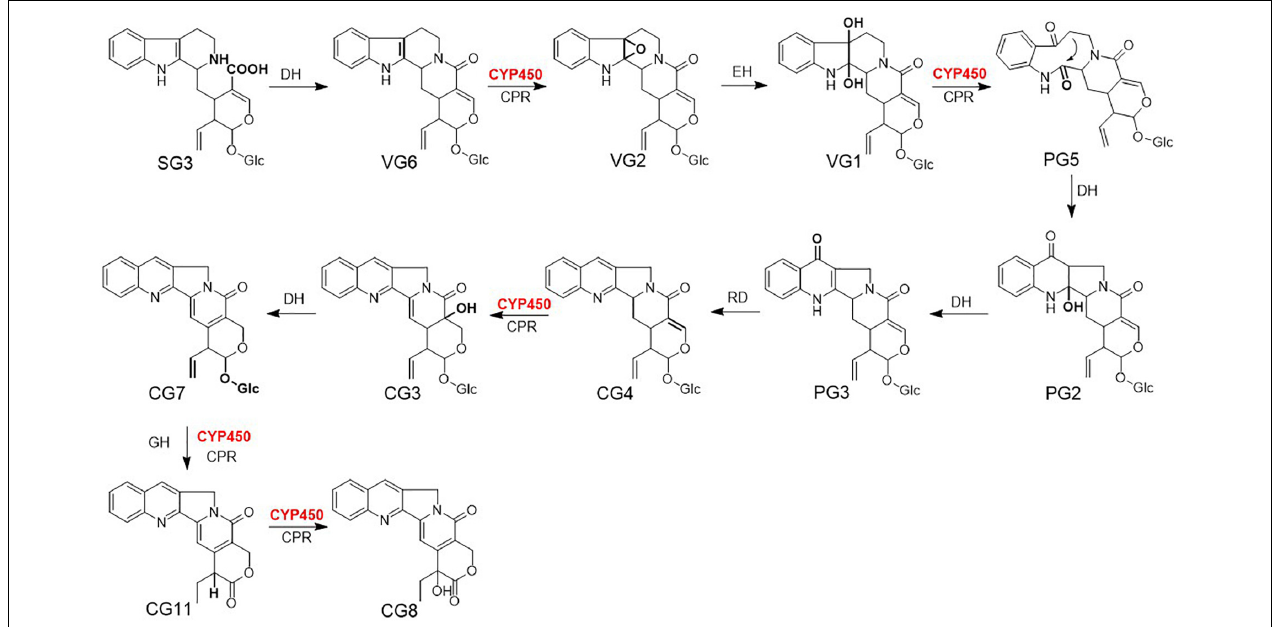
FIGURE 1 | The downstream biosynthetic pathway for camptothecin (CPT) in Camptotheca acuminata . DH, dehydratase; CYP450, cytochrome P450; CPR, cytochrome P450 reductase; EH, epoxide hydrolase; RD, reductase; GH, glucose hydrolase; SG3, strictosidinic acid; VG6, strictosamide; VG2, strictosamide epoxide; VG1, strictosamide diol; PG5, strictosamide ketolactam; PG2, 2-hydroxypumiloside; PG3, pumiloside; CG4, deoxypumiloside; CG3, 16-hydroxy-15, 16-dihydrocamptothecoside; CG7, camptothecoside; CG11, 20-deoxycamptothecin; CG8, camptothecin. The catalytic site of each step is marked in bold.